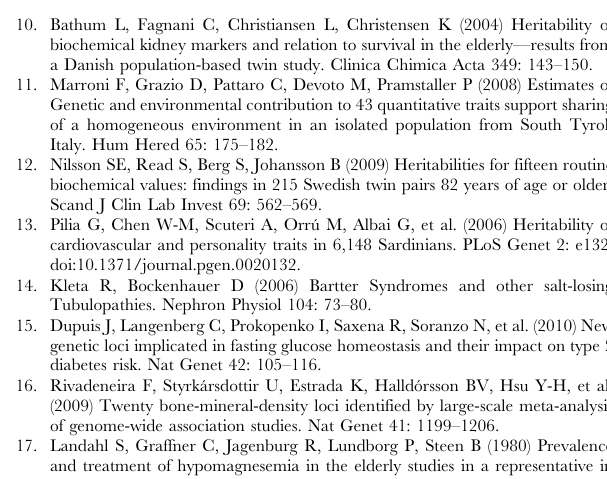
Table S8 Association between systolic and diastolic blood pressure with the lead replicated SNPs showing genome-wide significant associations with serum magnesium concentrations in the CHARGE